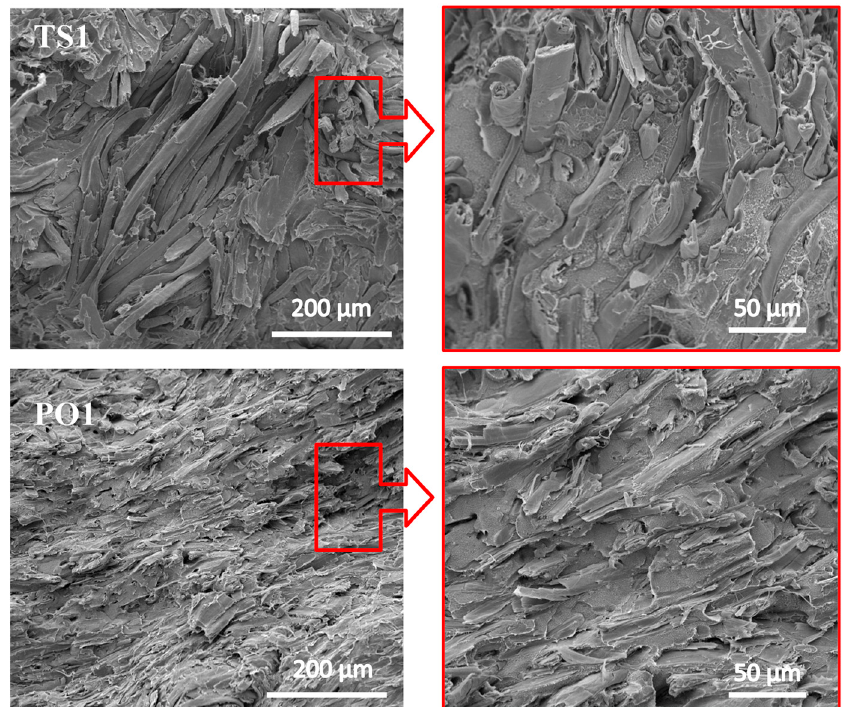
Figure 3. SEM images of the cross section of pulp fiber/HDPE composites. The right image corresponds to the circled region of left image. Composite TS1: wet pulp fiber/HDPE mixture was dried by twin-screw extruder. Composite PO1: wet pulp fiber/HDPE mixture was dried by prepressing and oven.